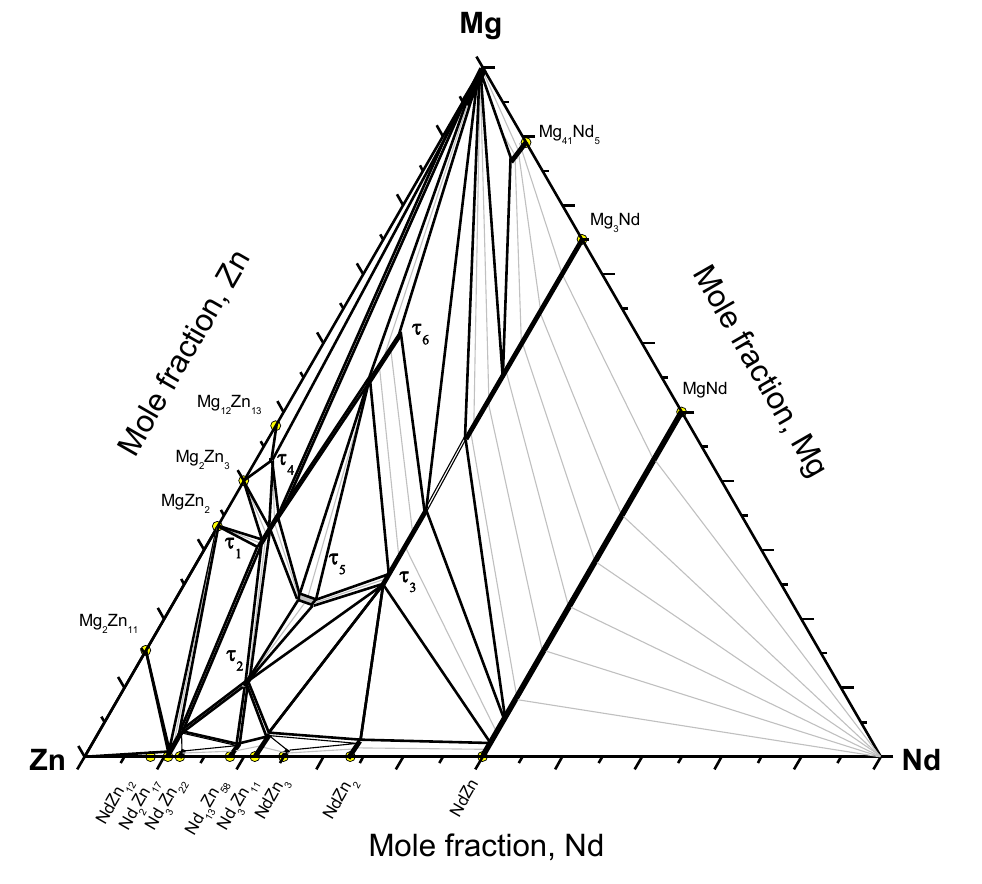
Figure 11. The Mg-Nd-Zn isothermal section at 300